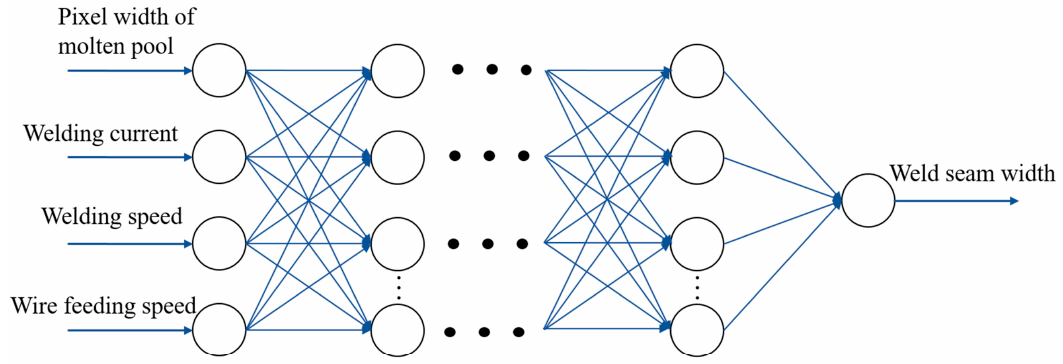
Figure 14. Network structure of weld width prediction based on BP neural network.